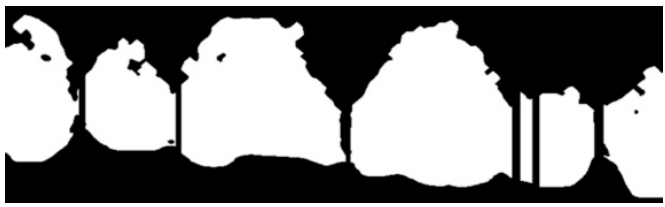
Figure 10. Shows the erosion area.